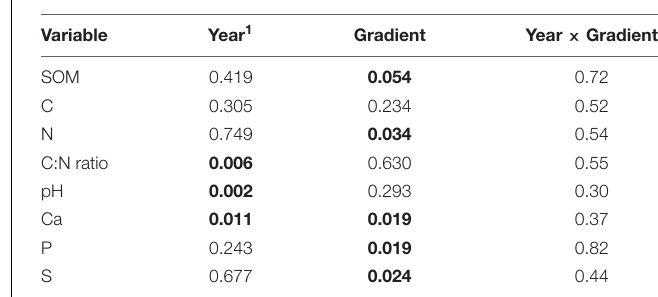
TABLE 1 | P values for repeated GLMM (SAS GLIMMIX) where “year” is for the years 2001 and 2018, “gradient” is the urban-rural gradient, and “year × gradient” is the interaction between year and gradient, i.e., urban 2001 versus urban 2018, at the site level ( n = 12